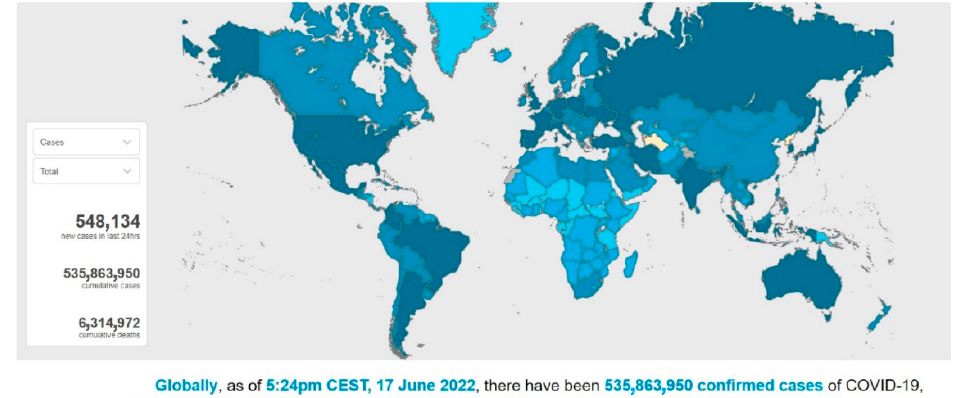
Figure 1. A screenshot of the interactive dashboard of COVID-19 global cases by the World Health Organization. This dashboard is continually updated and can be accessed at https://covid19.who.int/ (accessed on 17 June 2022).